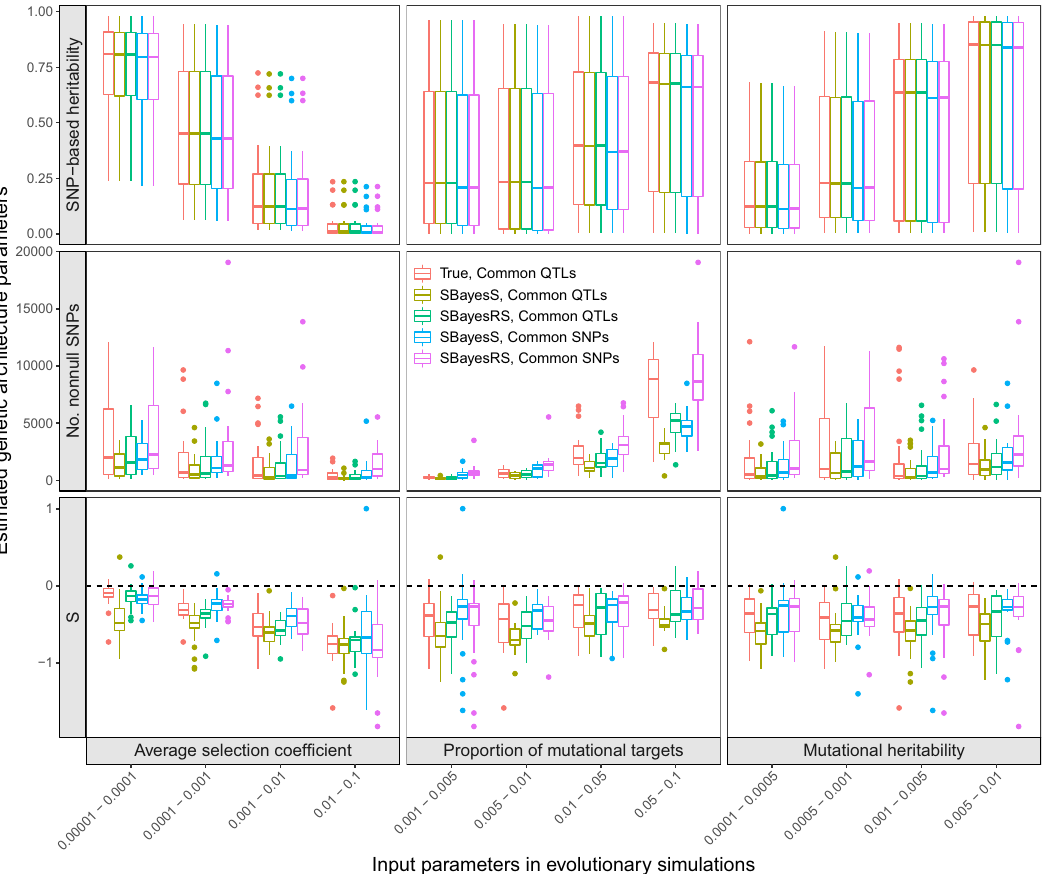
Fig. 4 Variational patterns of the estimated genetic architecture parameters under different scenarios of evolutionary simulations. The selection coef fi cients followed a mixture distribution, and the Simons et al. pleiotropic model with n t = 1 was used to generate genetic effects (see the “ Methods ” section). The x -axis shows the values of three input parameters in the evolutionary simulations. The y -axis shows the distribution of the genetic architecture parameter estimates, where the polygenicity parameter is represented by the number of nonnull SNPs for better benchmarking. Colours indicate the following methods: “ True, Common QTLs ”— parameters computed directly from the simulated genetic effects of all common causal variants; “ SBayesS, Common QTLs ” (or “ SBayesRS, Common QTLs ” ) — SBayesS (or SBayesRS) estimates using the genotype data of the common causal variants, “ SBayesS, Common SNPs ” (or “ SBayesRS, Common SNPs ” ) — SBayesS (or SBayesRS) estimates using the genotype data of 36k common SNPs. Each box plot shows the results of 25 independent simulation replicates. The band inside the box is the median, the bottom and top of the box are the fi rst and third quartiles, respectively (Q1 and Q3), and the lower and upper whiskers are Q1 – 1.5 × IQR and Q3 + 1.5 × IQR, respectively, where IQR = Q3 –